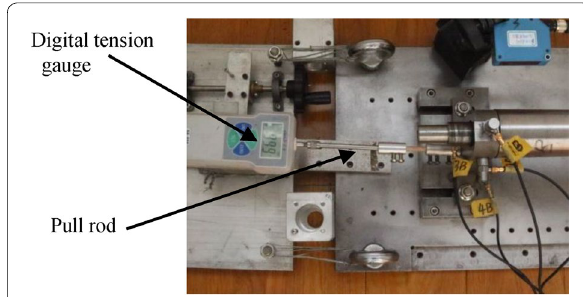
Figure 7 Mechanism for applying axial force